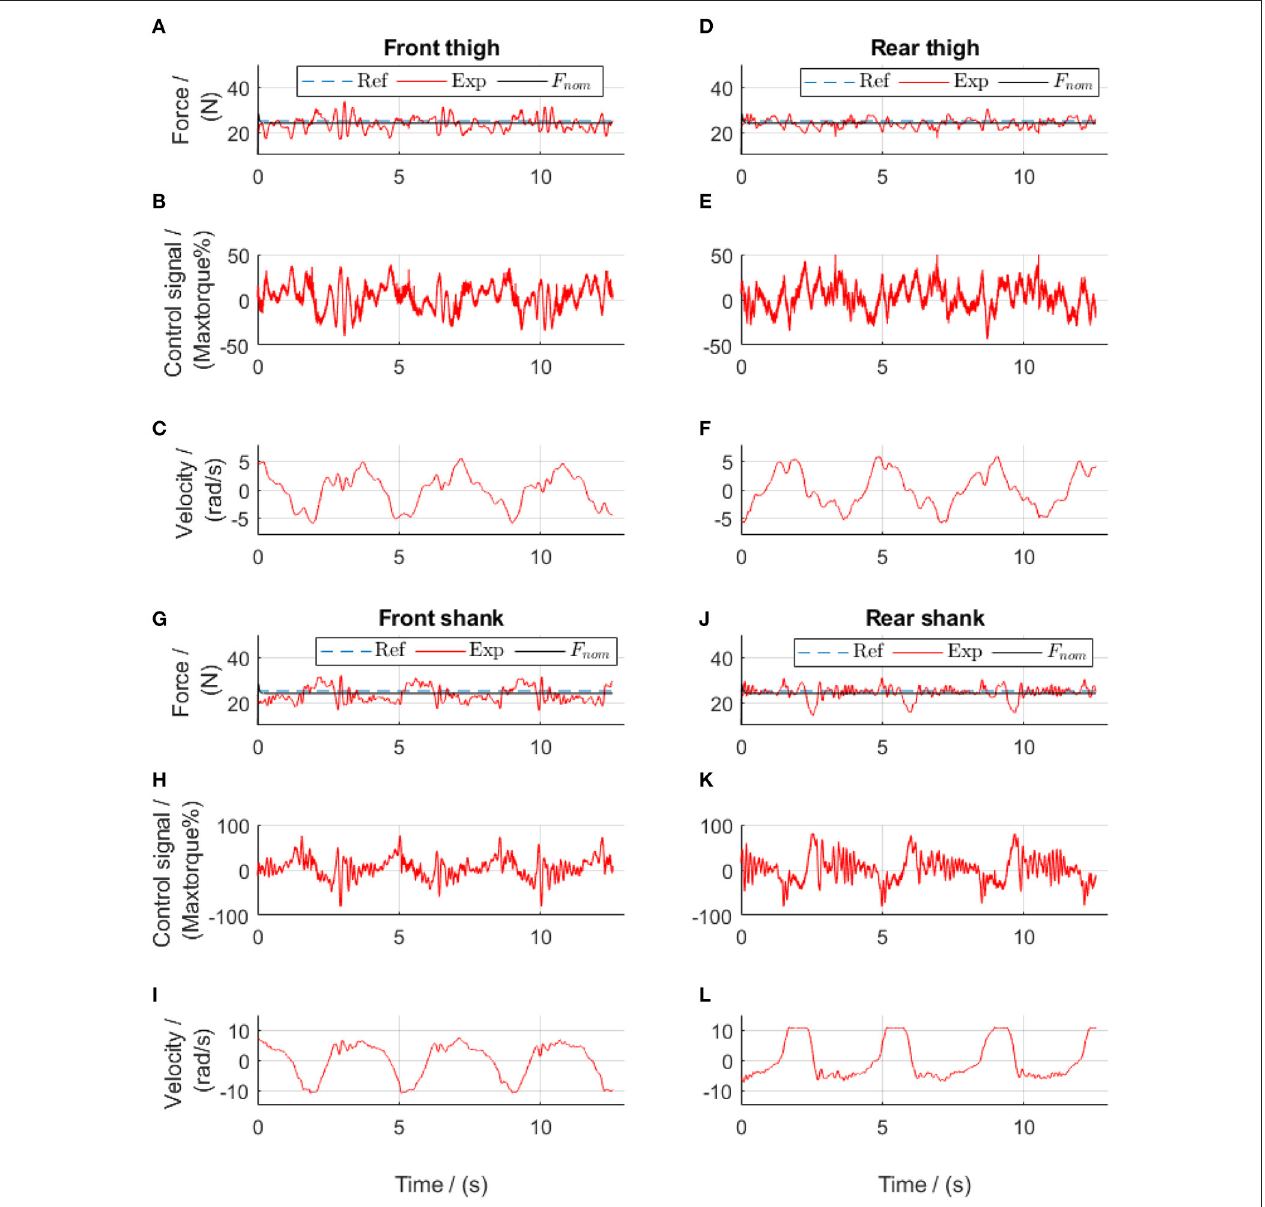
FIGURE 13 | Constant-reference force control during walking using force-feedback lead controllers and velocity-feedforward lead compensators. Subplots (A–C) show results from the front thigh actuator, (D–F) from the rear thigh actuator, (G–I) from the front shank actuator while (J–L) from the rear shank actuator. Ref, references; Exp, experimental values; F nom , the simulated target. The positive angular velocity of the front actuators in (C,L) means that the right leg moved backwards.